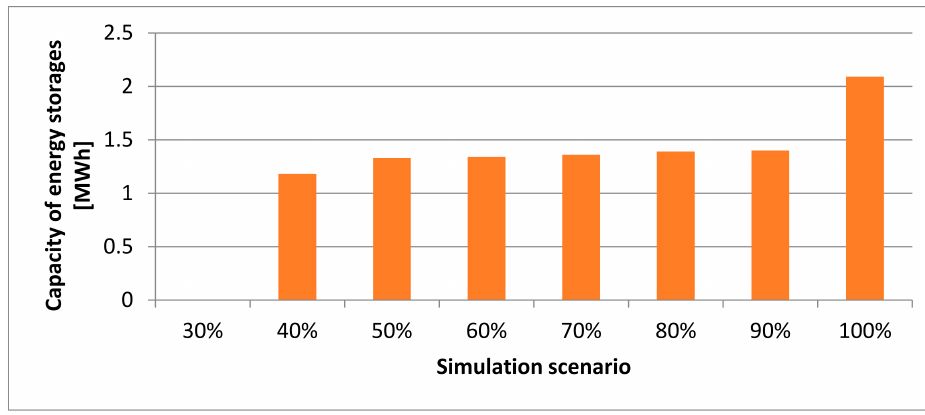
Figure 9. Capacity of energy storages structure for simulation